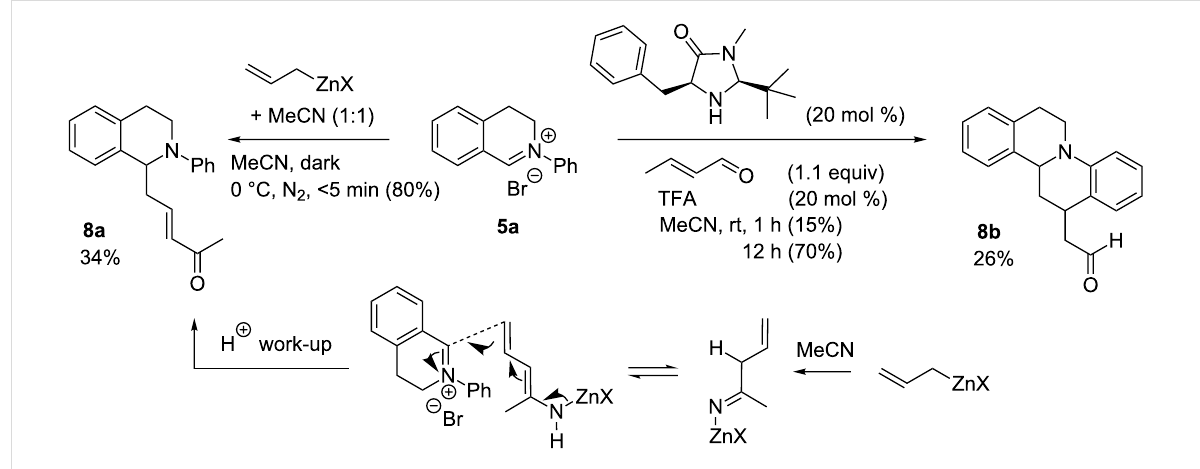
Figure 3: Proposed mechanism for formation of side-product 8a . Analogous reactivity in the formation of cyclic product 8b under enamine catalysis. LC–MS (%) yields in parenthesis. Isolated yields, %, after chromatography not in parenthesis.